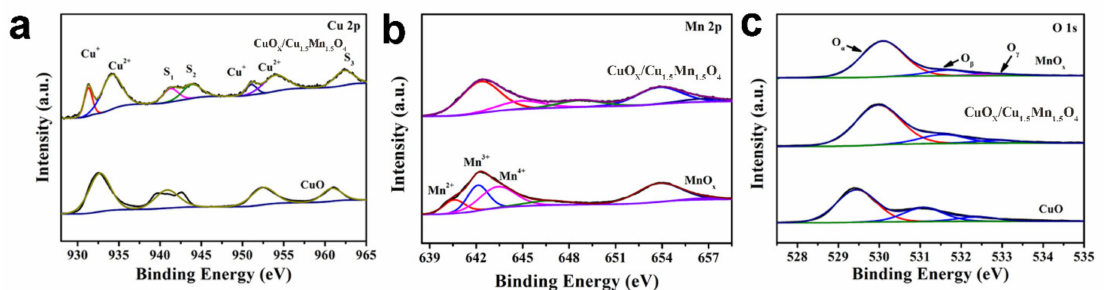
Figure 4. ( a )Cu2p; ( b )Mn2p; ( c )O1sspectraofMnO x ,CuO x /Cu 1.5 Mn 1.5 O 4